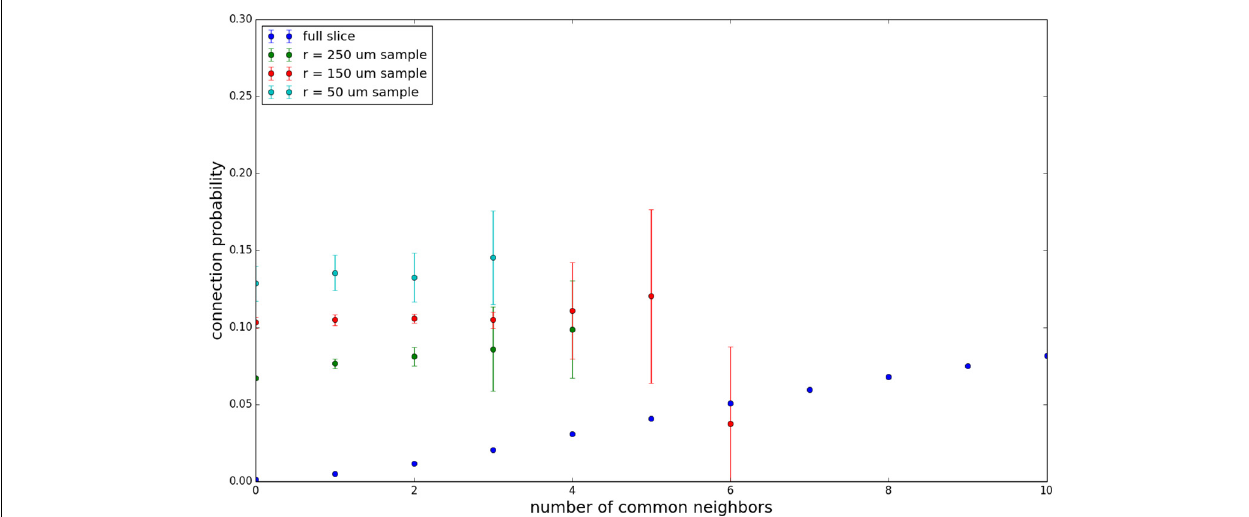
FIGURE 4 | Common neighbor clustering for 500 µ m slice: pairwise connection probability as a function of number of commonly connected neighbors. Error bars indicate standard error of the mean. Average over five populations.